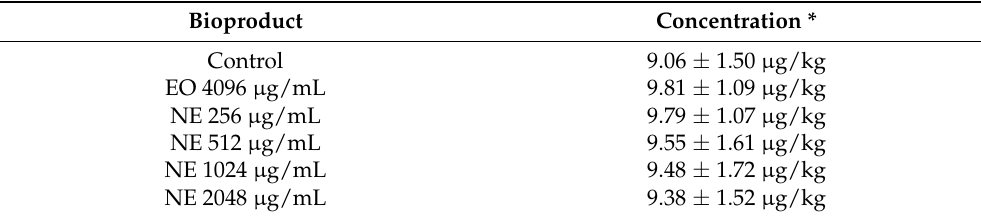
Table 5. AFB1 production by A. flavus colonies in the presence of EO and NE at 48, 72, and 96 h.